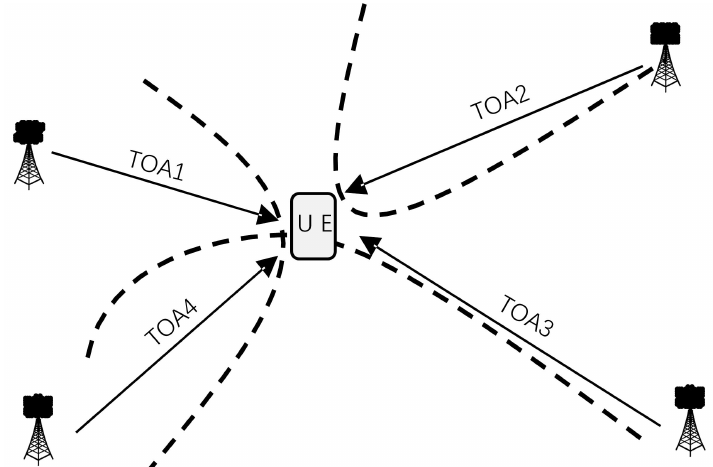
Figure 5. Hyperbolic positioning